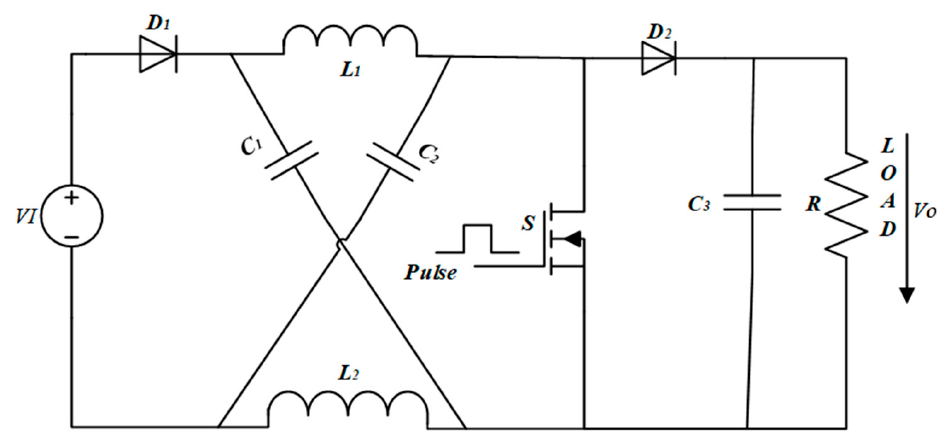
Figure 2. The traditional Z-source DC-DC converter.